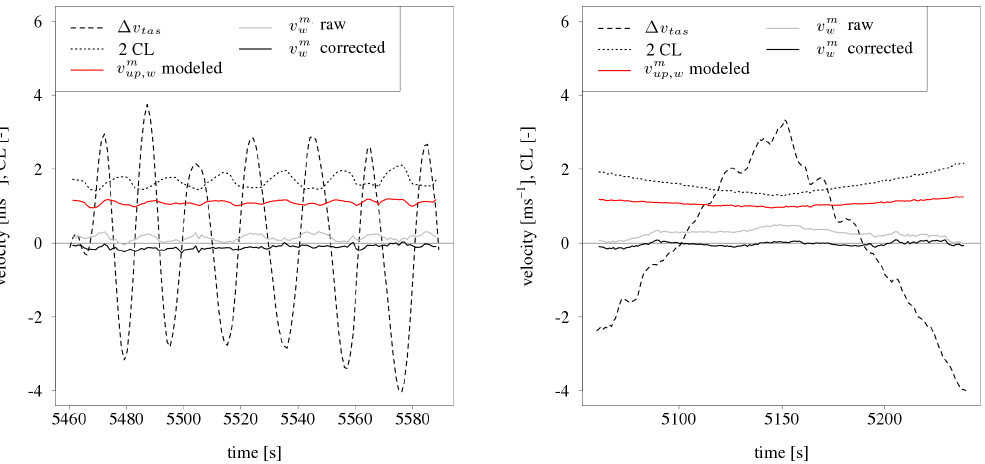
Fig. 8. Forced oscillation pattern (VW3, left) and level acceleration–deceleration pattern (VW1, right) on 25 June 2008. For improved legibility the average is subtracted from true airspeed ( 1v tas ) and lift coefficient is inflated by the factor two (2 CL ). Displayed is the vertical wind ( v m w ) before (raw) and after (corrected) correction for dependence on the lift coefficient. For comparison the modelled upwash ( v m up ,w ) is presented, which was computed using Eq. (3) and decomposed and rotated from wing- into meteorological coordinates using Eq. (A13).